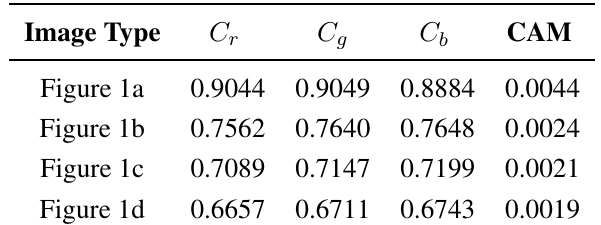
Table 1. Mean RGB values of the white region in Figures 1 and the corresponding color alignment measure (CAM) values.